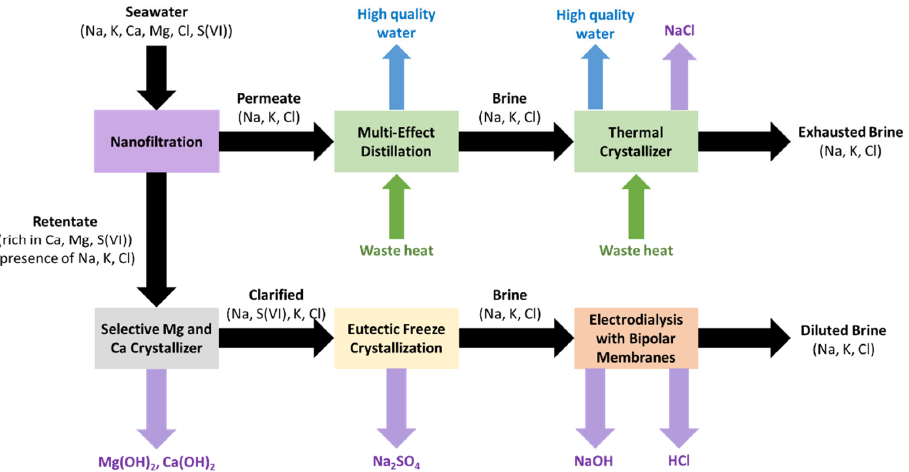
Figure 1. Scheme of the treatment chain evaluated in Case Study 1 (Lampedusa, Italy) within the WATER ‐ MINING project (adapted from Culcasi et al. [18]). WATER-MINING project (adapted from Culcasi et al.